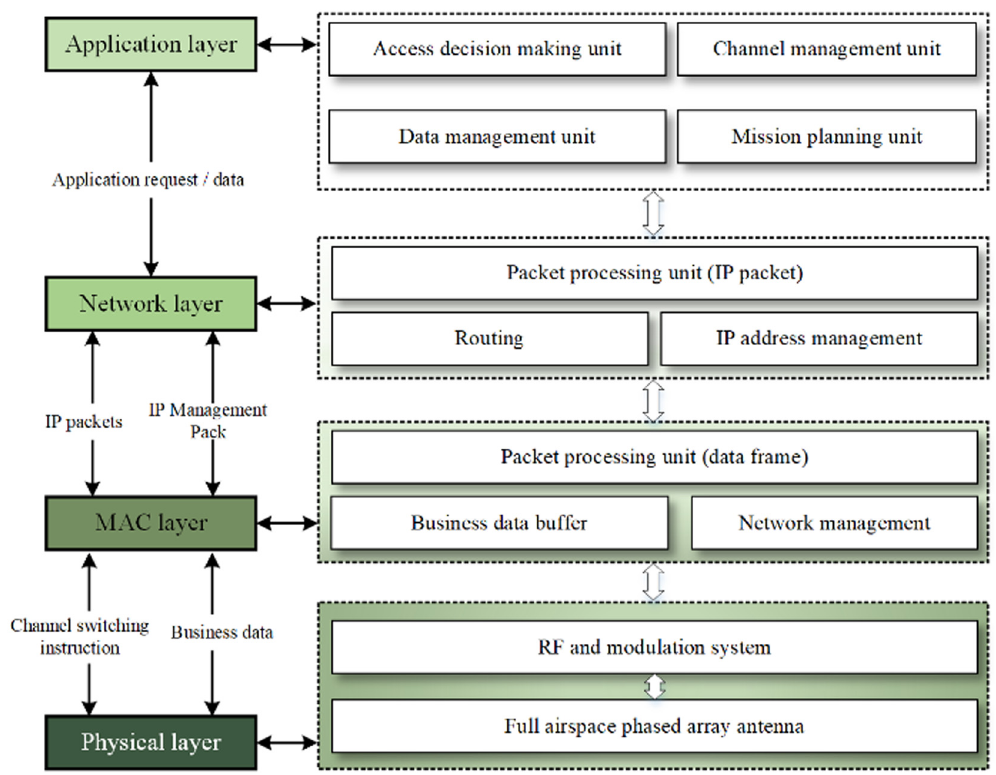
Figure 7: The protocol stack of the AOE TT&C